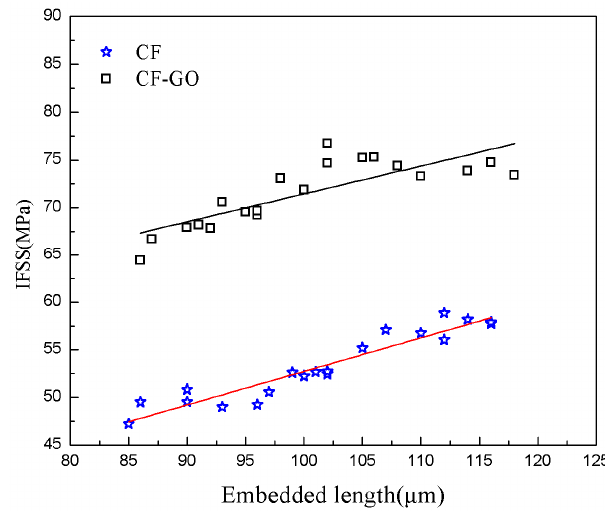
Figure 8. Regression approximation for the data of the interfacial shear strength (IFSS) versus embedded lengths of the microdroplet specimens.